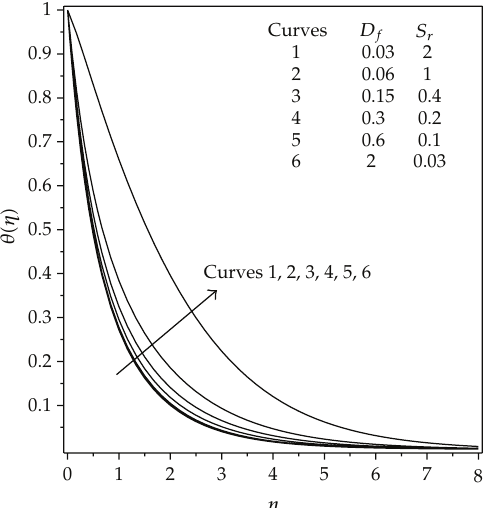
Figure 8: Temperature profiles for di ff erent values of D f and S r when Pr (cid:9) 0 . 78, Sc (cid:9) 0 . 6, r (cid:9) 1, M (cid:9) 1, and f 0 (cid:9)